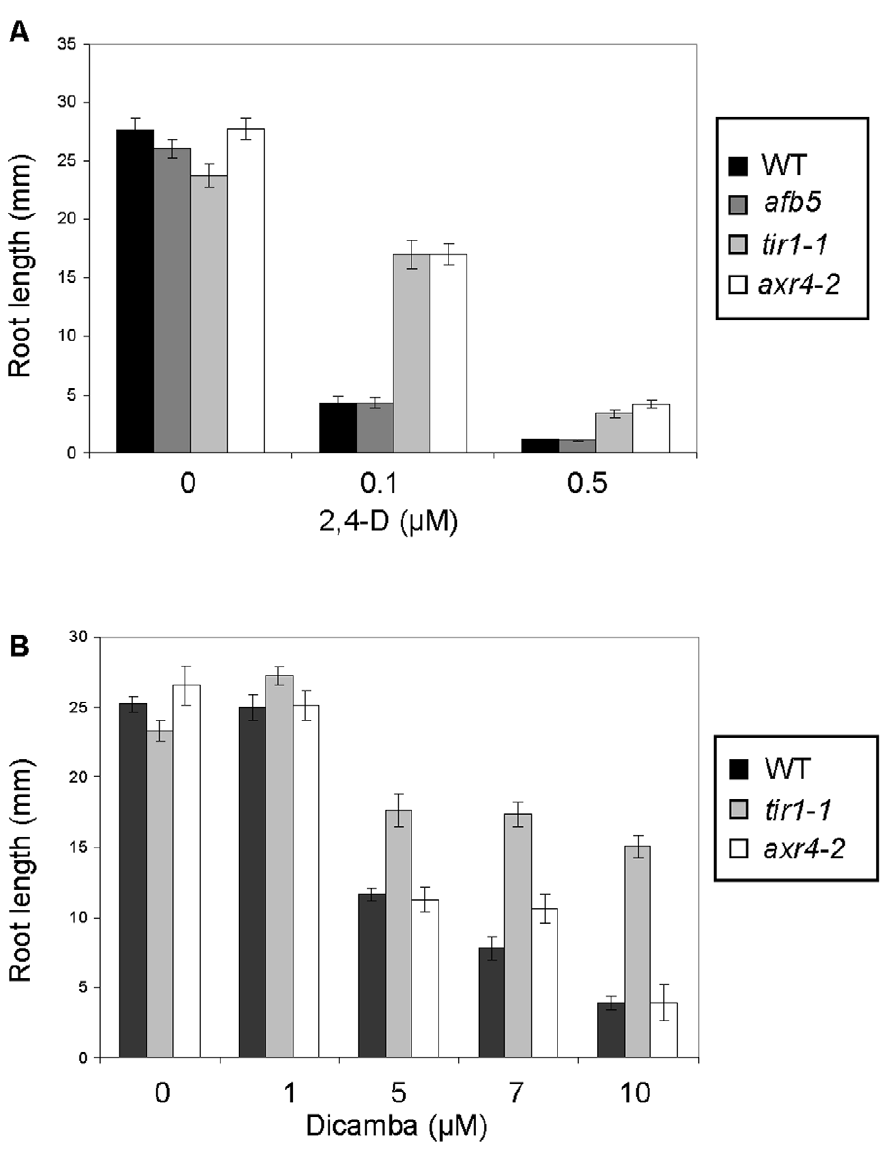
Figure 2. Differential effects of 2,4-D and dicamba on the root growth of WT and auxin mutant plants. The data represents primary root length measured after 8 days on media with various concentrations of herbicide. Measurements were taken on at least 10 seedlings per plate and at least 2 plates per treatment. Error bar indicated standard error (sem). A, Effects of 2,4-D (0, 0.1 m M, and 0.5 m M) on root length compared between WT, axr4-2 , afb5 , and tir1-1 plants. B, The effects of dicamba (0, 1, 5, 7 and 10 m M) on the root lengths of WT, axr4-2 , and tir1-1 plants.